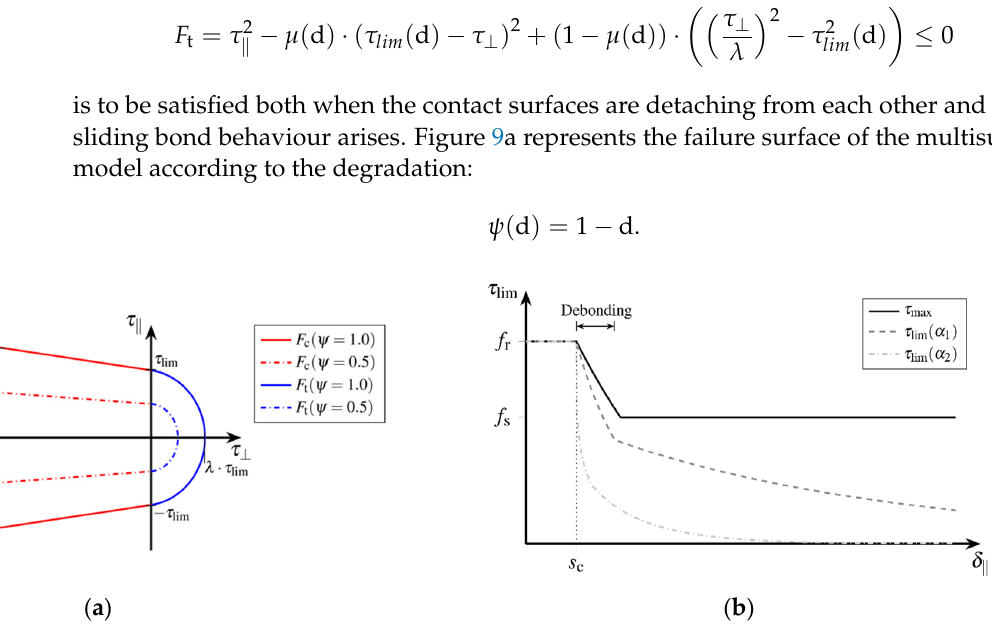
Figure 9. Failure model (reprinted from [27]): ( a ) Failure surface addicted to the degradation ψ ( d ) and ( b ) evolution of bond capacity with increasing relative displacement.